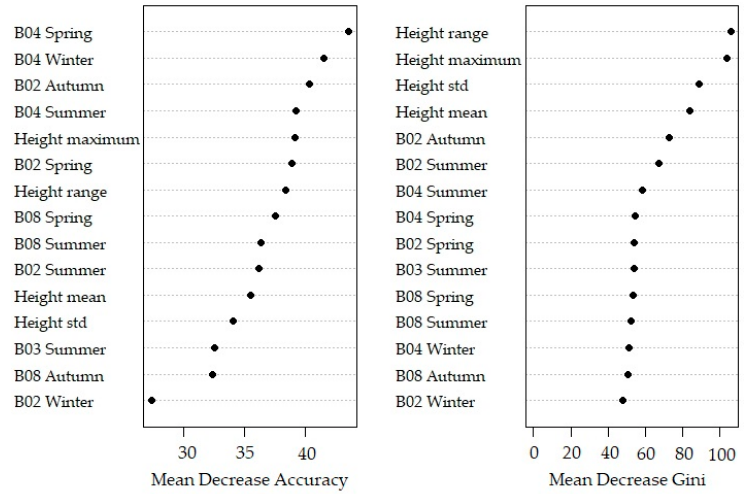
Figure 5. Variable importance plot of the random forest of all variables on species level.